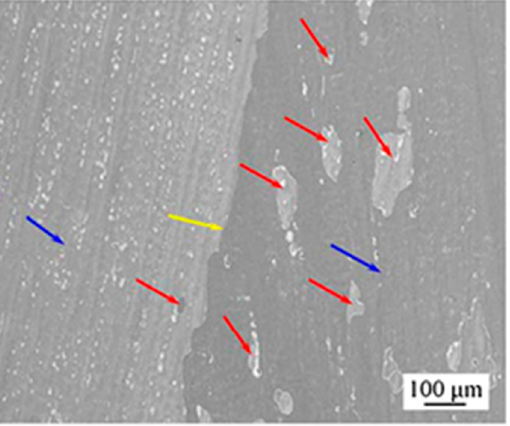
Figure 18. SEM image of GCGs in the microstructure of Cu-Sn alloy after TZCC [34]. Microstructural investigation using an optical microscope and the EBSD technique by Luo et al. [36] proved that initial nucleation of small grains resulted in the front of the solid–liquid interface region during TZCC. The angular difference between [0 0 1] colum- nar grains and the direction of heat flow was found to be less than 19°, which was at- tributed to the faster growth rate. Similarly, the slower growth rate for small grains was because of the magnitude of the angle exceeding 19° between [0 0 1] small grains and the direction of heat flow. When both columnar and small grains were in contact, the growth of columnar grains was more pronounced when compared to small grains. This led to the formation of GCGs and much smaller grains at the grain boundaries of columnar grains. Microstructure and its quantification have been well-explained by Luo et al. [36] after the TZCC process. Finally, Luo et al. [37] made use of ProCast software that simulates the TZCC process to analyse solute (Sn) distribution and surface segregation taking place along the process. Cu-4.7wt%Sn alloy with a broader solid–liquid phase zone was under investigation. Figure 19 shows that the solidification of the alloy was first found at the centre and initiated the ‘ Ʌ ’ structure. Moreover, a narrow gap was formed between the solid/liquid interface and a wall in the two-phase zone mould was created. This formation of the gap was attributed to the formation of the ‘ Ʌ ’ structure. The alloy solidified along the direction opposite to the direction of continuous casting. SEM analysis revealed that redistribution of Sn solute occurred, which was the reason for the solid grain nucleation near the walls of the two-phase zone mould. Luo et al. [37] have also proved that the liquid enriched Sn solute caused by solid grain growth will increase the amount of Sn solute at the solid–liquid interface.